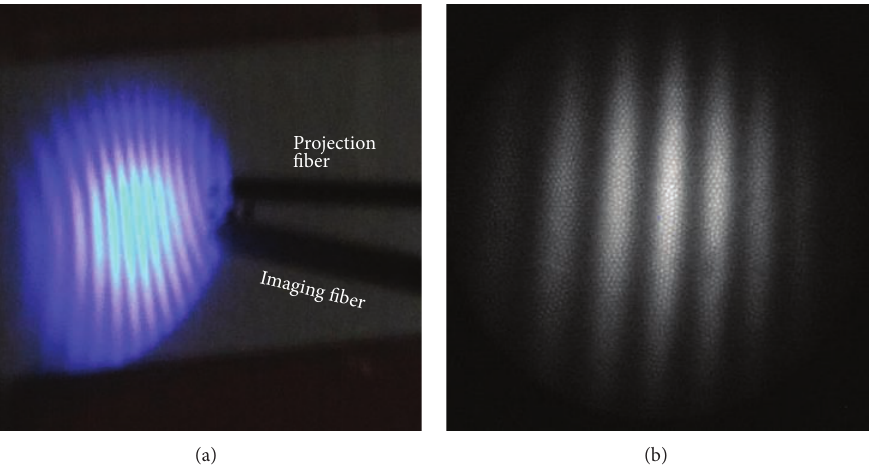
Figure 5: A fringe pattern projected on a reference plane, as seen (a) by an observer and (b) by the camera attached to the rigid fiber scope.